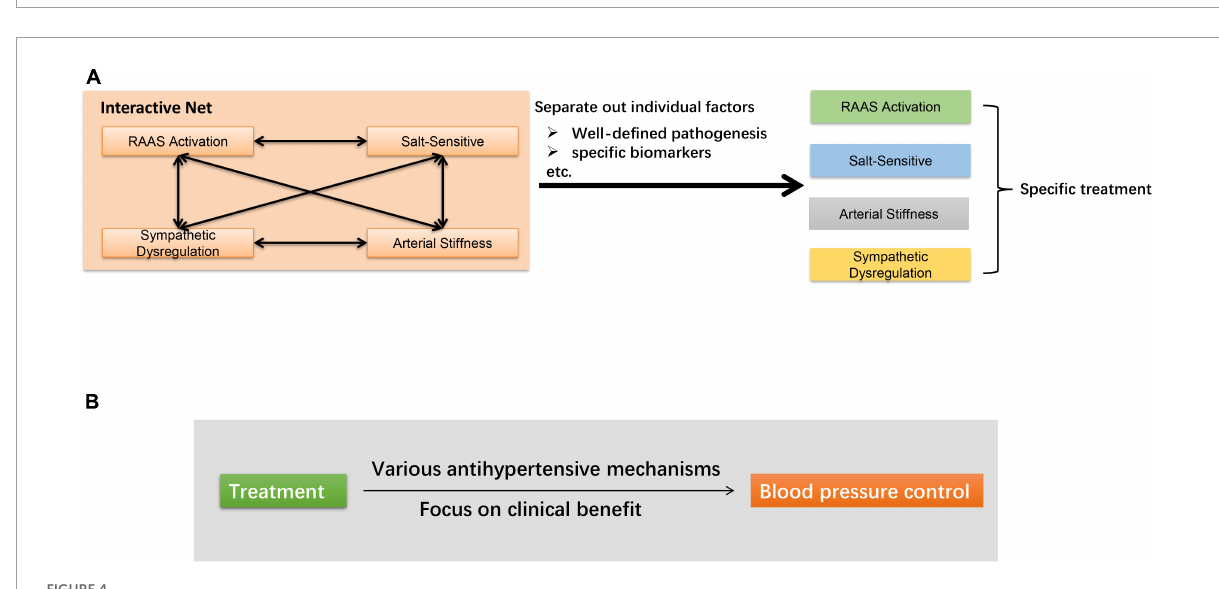
FIGURE4 Main research directions to further optimize the treatment of hypertension. (A) Sort out the net and separate out the role of individual factors. (B) Focus on clinical antihypertensive